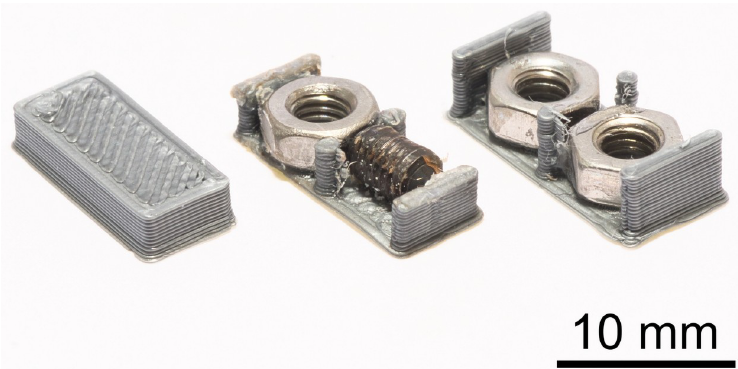
Fig 1. Light, medium, and heavy (from left to right) dummy tags constructed based on the weights and dimensions of three commonly used radio transmitters.